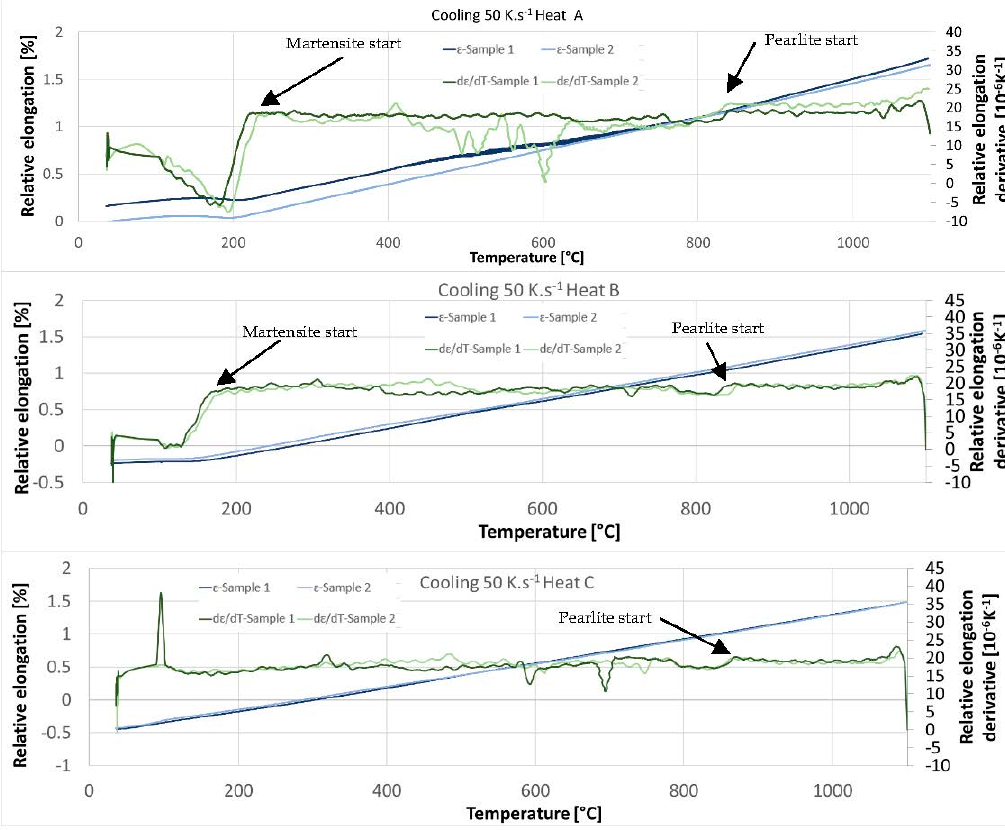
with increasing aluminium content. Another difference is the decreasing proportion of the transformed structure—martensite—with increasing aluminium content, which contrib- Figure 14. Dilatometric curves and their derivation—cooling at 50 °C s − 1 . utes to the stability of the ferrite.